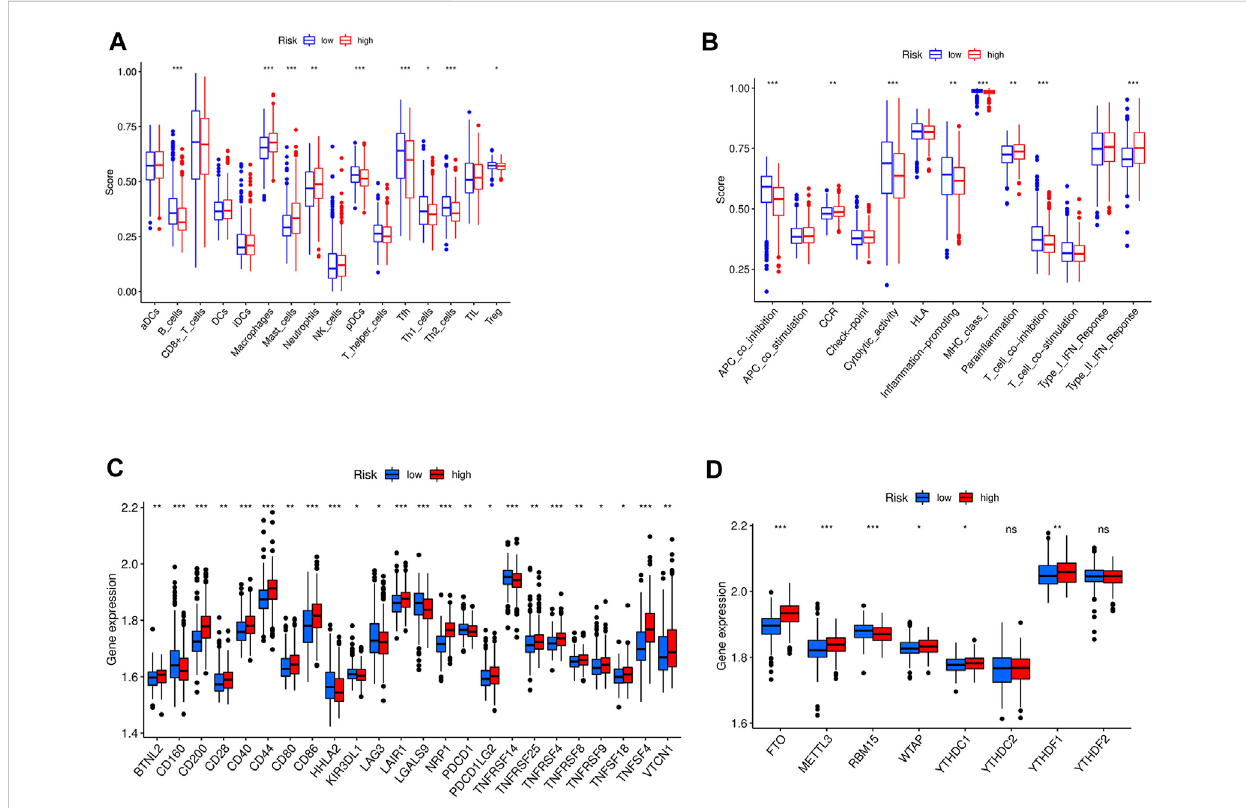
FIGURE 10 (A) The immune cell between high-risk and low-risk groups in entire cohort; *** p < 0.05, ** p < 0.01, * p < 0.001; (B) The immune related function betweenhigh-riskandlow-riskgroupsinentirecohort;*** p < 0.05,** p < 0.01,* p < 0.001; (C)